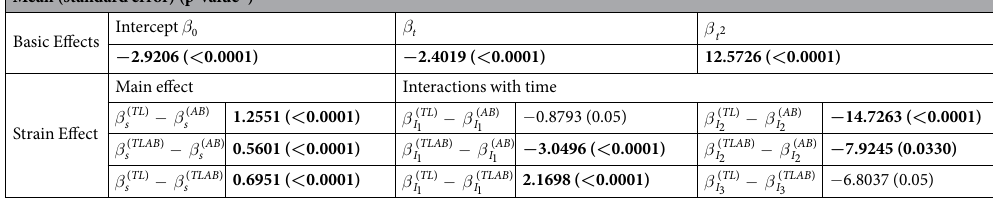
Table 1. The GLMM results of Light-On VMR from 1 to 30s for different WT strains at 6 dpf. * p-values of these tests were adjusted using the Benjamini–Hochberg procedure to control for Type I